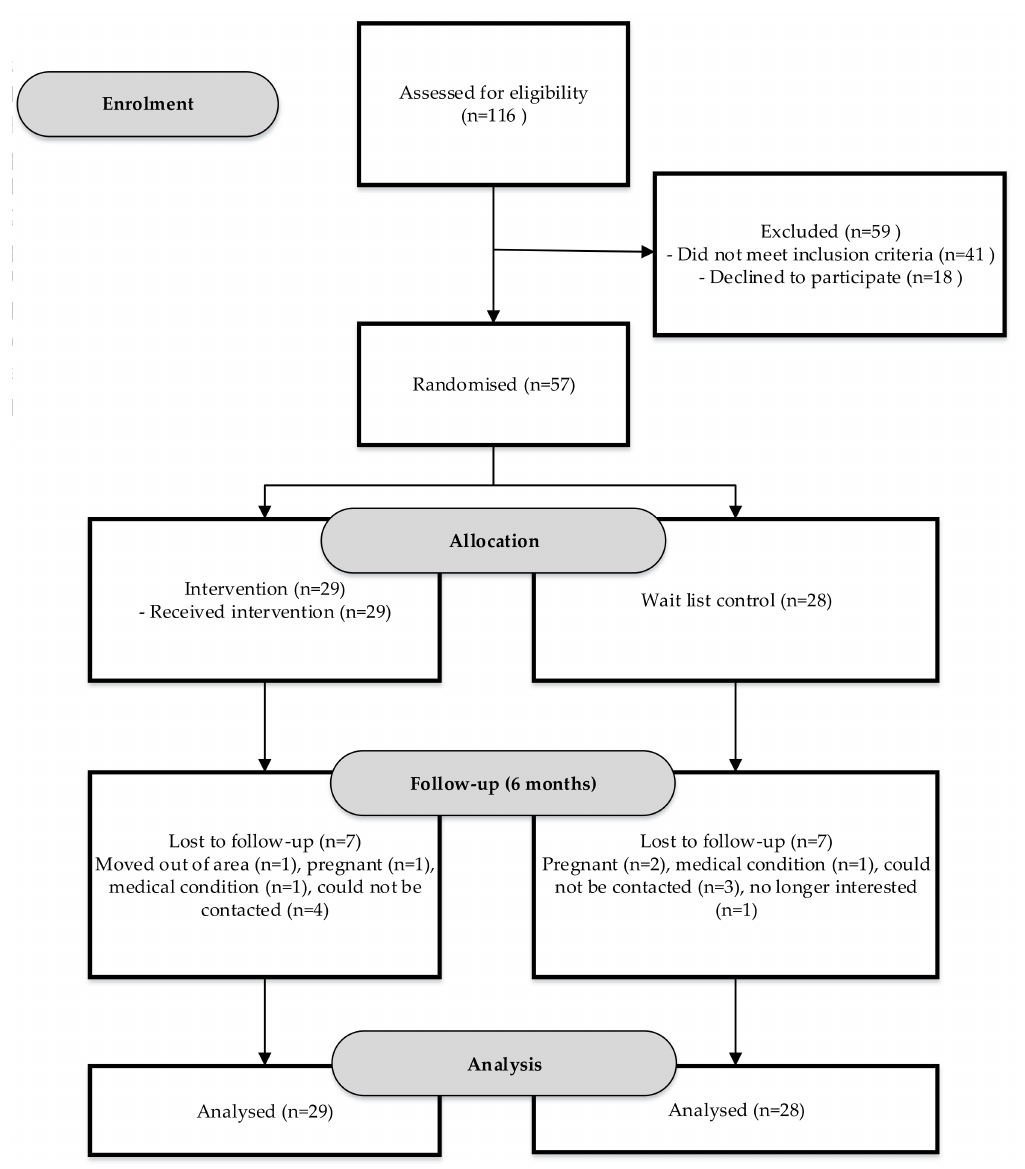
Figure 1. Flow diagram of young women recruited to the Be Positive Be Health e six-month weight loss program randomized controlled trial. Table 2. Baseline characteristics of young women ( n = 57) participating in the Be Positive Be Health e six-month weight loss program randomized controlled